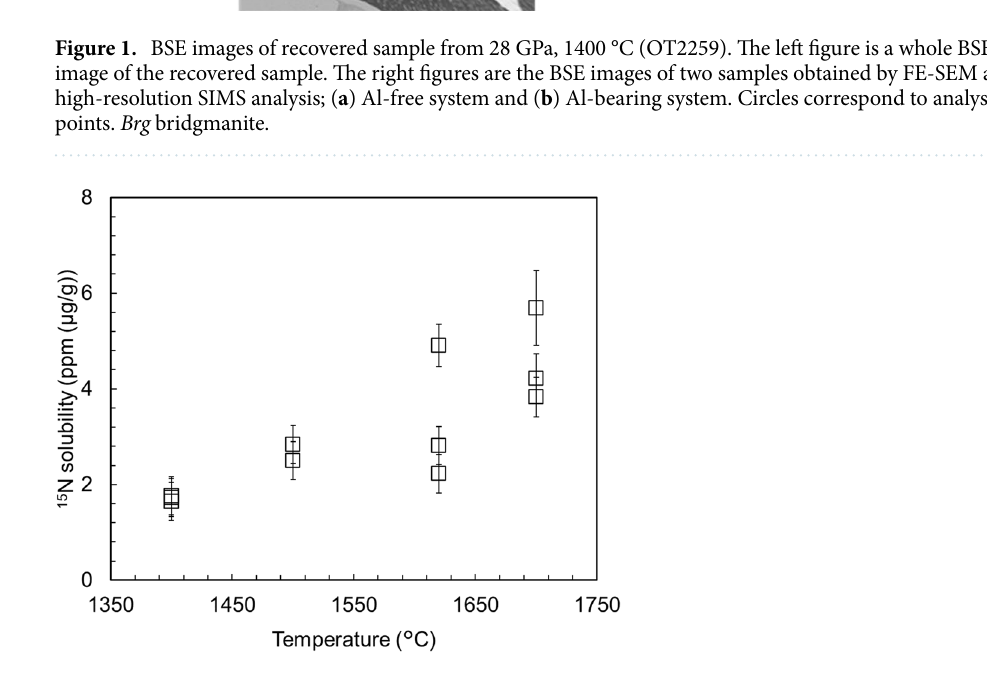
Figure 2. Plots depicting the nitrogen solubility in bridgmanite (MgSiO 3 ) at different temperatures. All data points represent the single measurement points of the